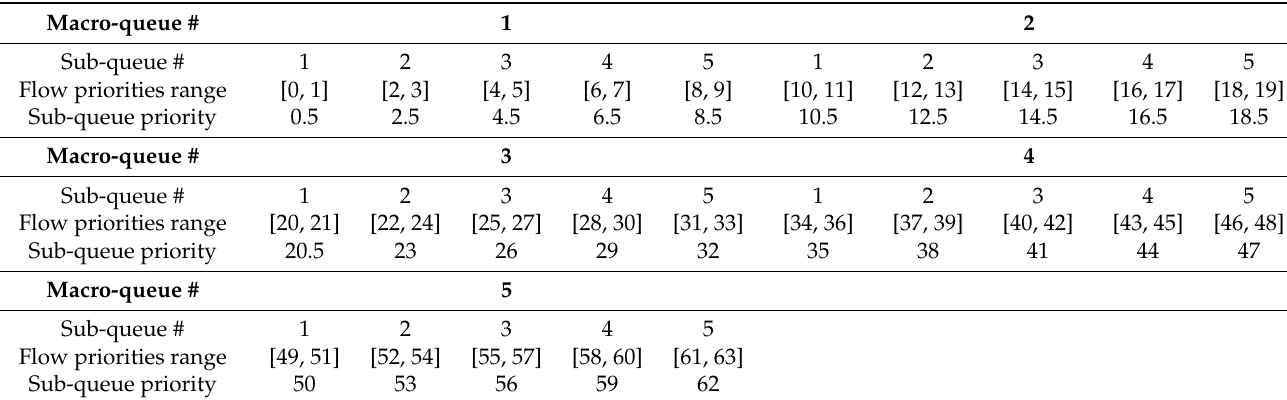
Table 10. Three macro-queues’ sub-queue priorities.